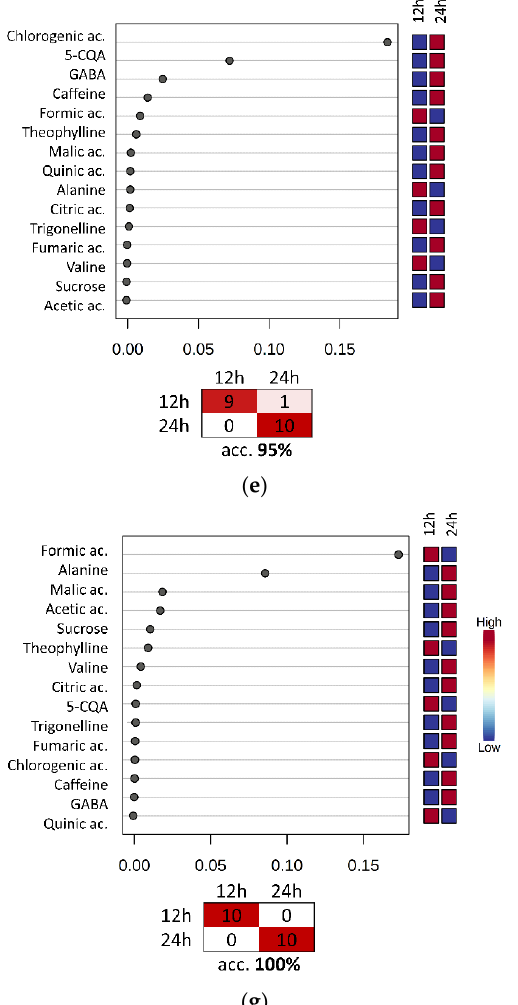
Figure 5. RF models on green coffee metabolites characterizing each variety according to 12 or 24 h of beans fermenta- tion. ( a ) catuai rojo; ( b ) maracaturra; ( c ) bourbon; ( d ) caturra; ( e ) pacamara; ( f ) tekesic; ( g ) bourbon rojo. Mean decrease accuracy values are reported on the orthogonal axis of each plot.